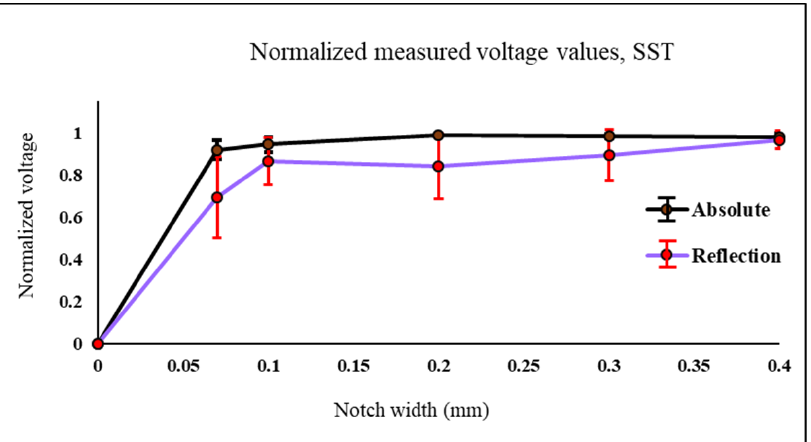
Figure 10. Normalized values of the measured voltage for both probes on top of plates made of stainless-steel with notches with different widths.